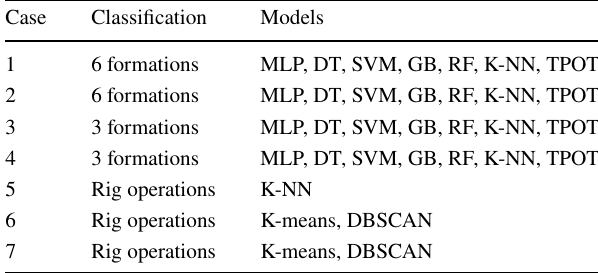
Fig. 5 Flowchart of model